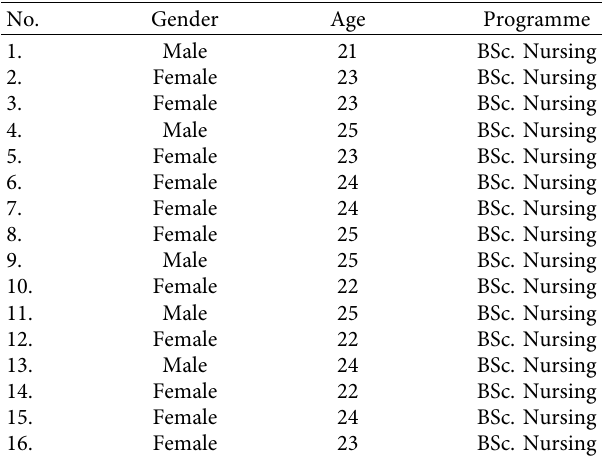
Table 1: Demographic characteristics of the